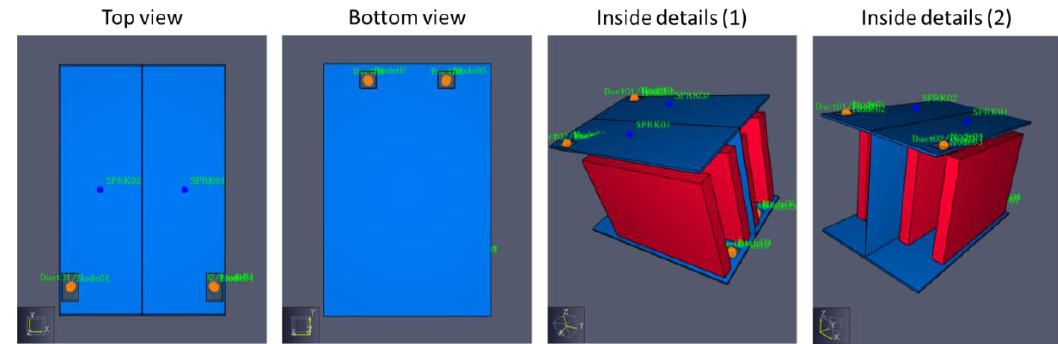
Figure 7. Battery room design (top view, bottom view, and inside details). Table 6. Technical data of battery package (one set).